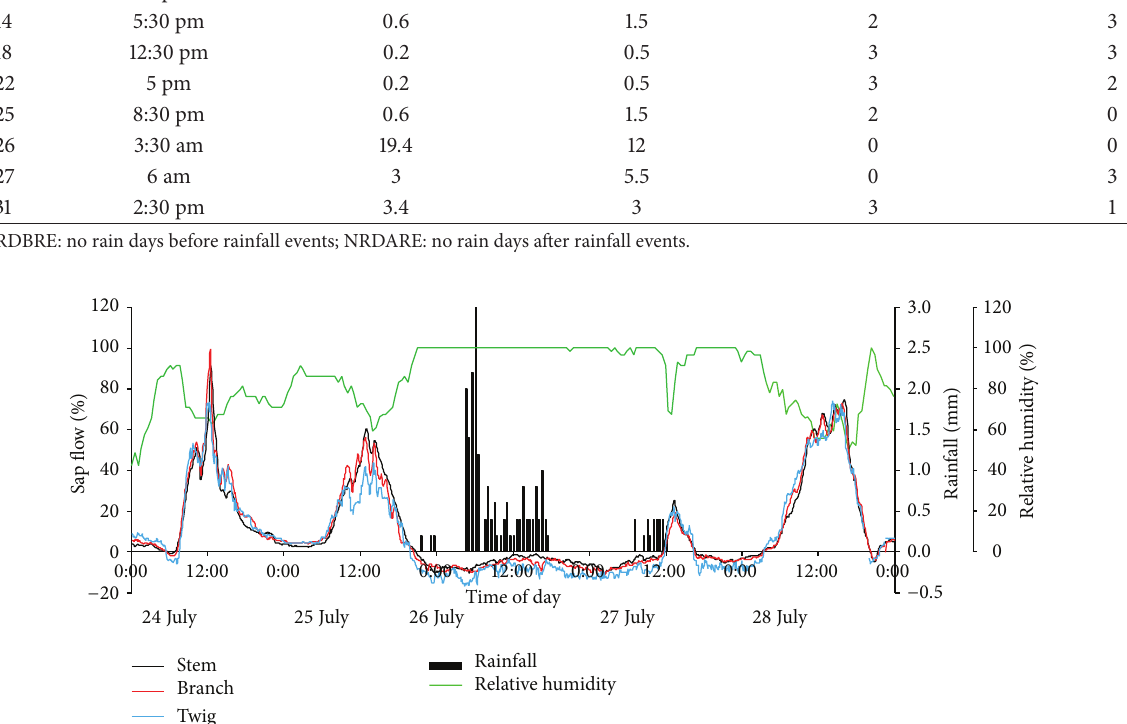
data from 2000 to 2013, > 72% of rainfall occurs between June and September. Table 3 presents rainfall events from the automatic weather station over July 2013 in the study area. Of these 12 rainfall events, eight occurred from late afternoon to early morning. This period was favorable for rain droplets to remain on the leaf surfaces for some time because of weak solar radiation. The time interval between the two rainfall events did not exceed 4 days, except one 12-day